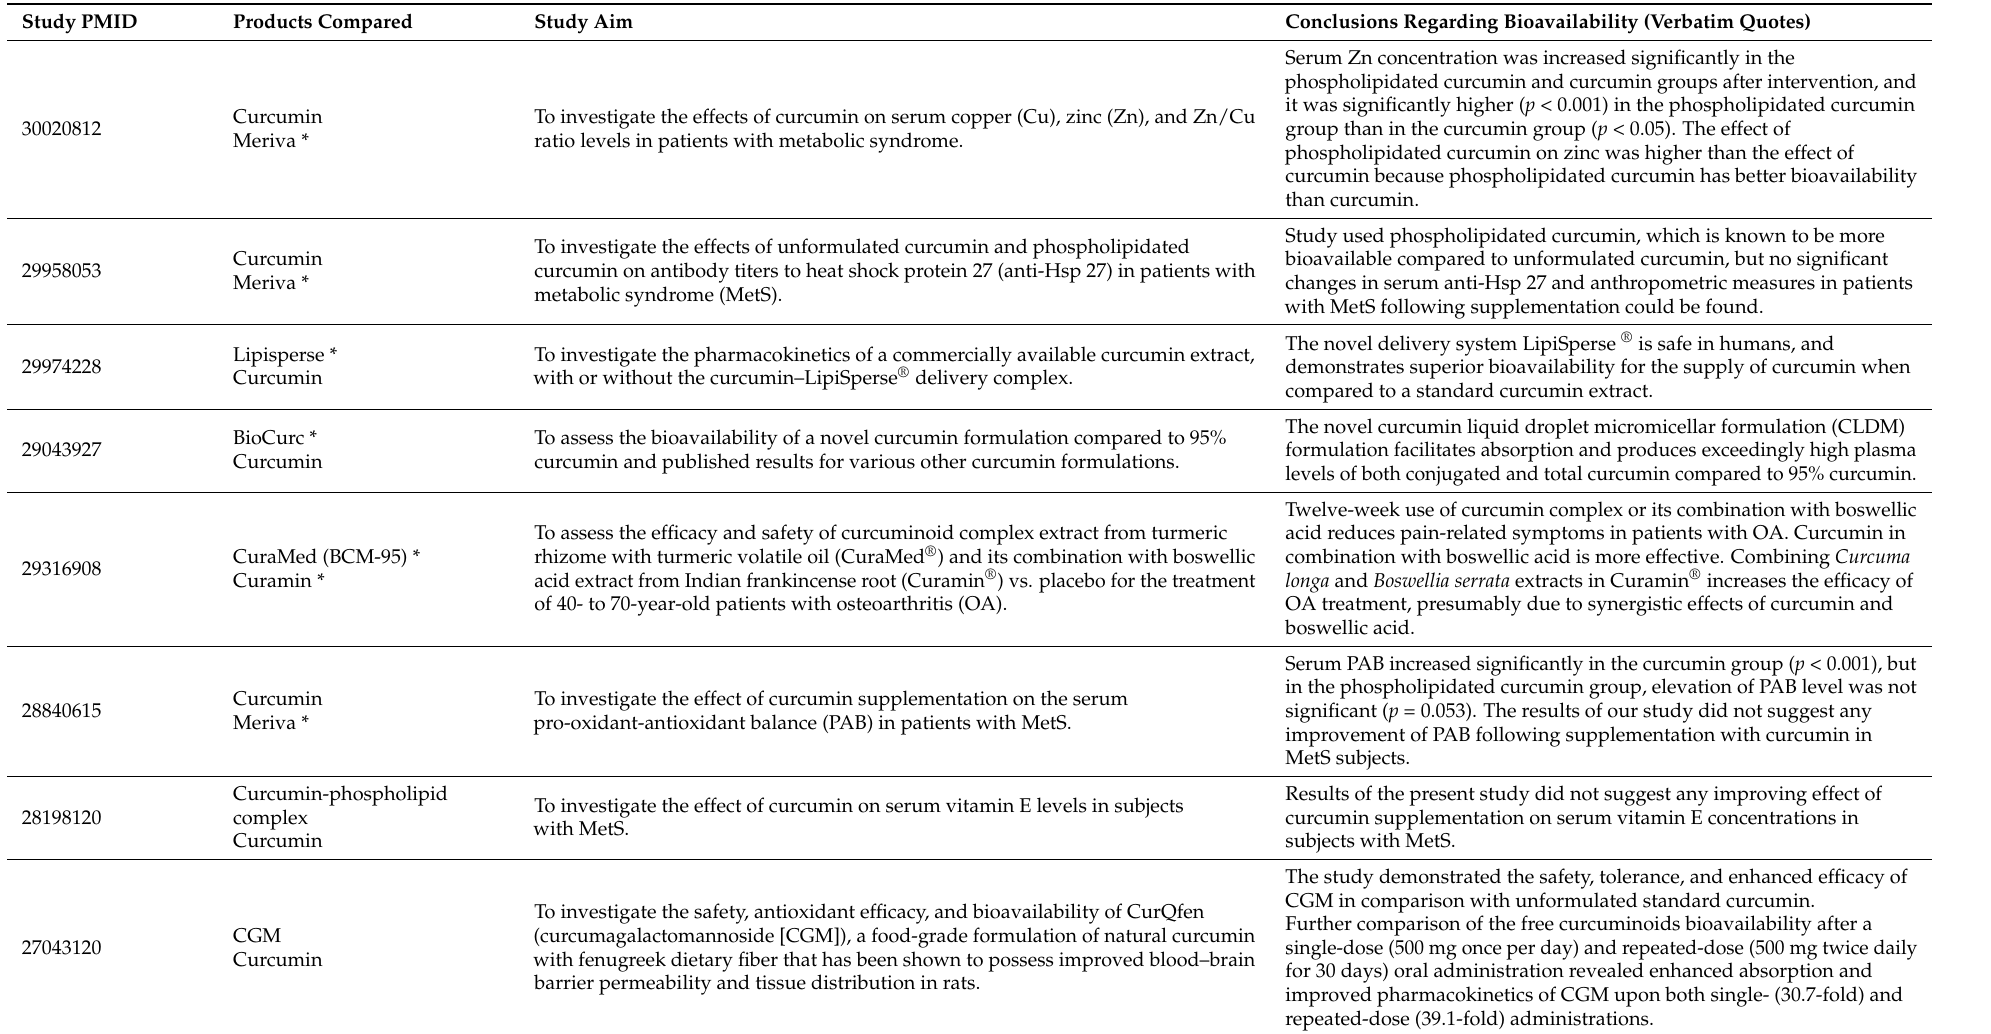
Table 4. Studies that have compared multiple curcumin products. Commercial names are marked with an